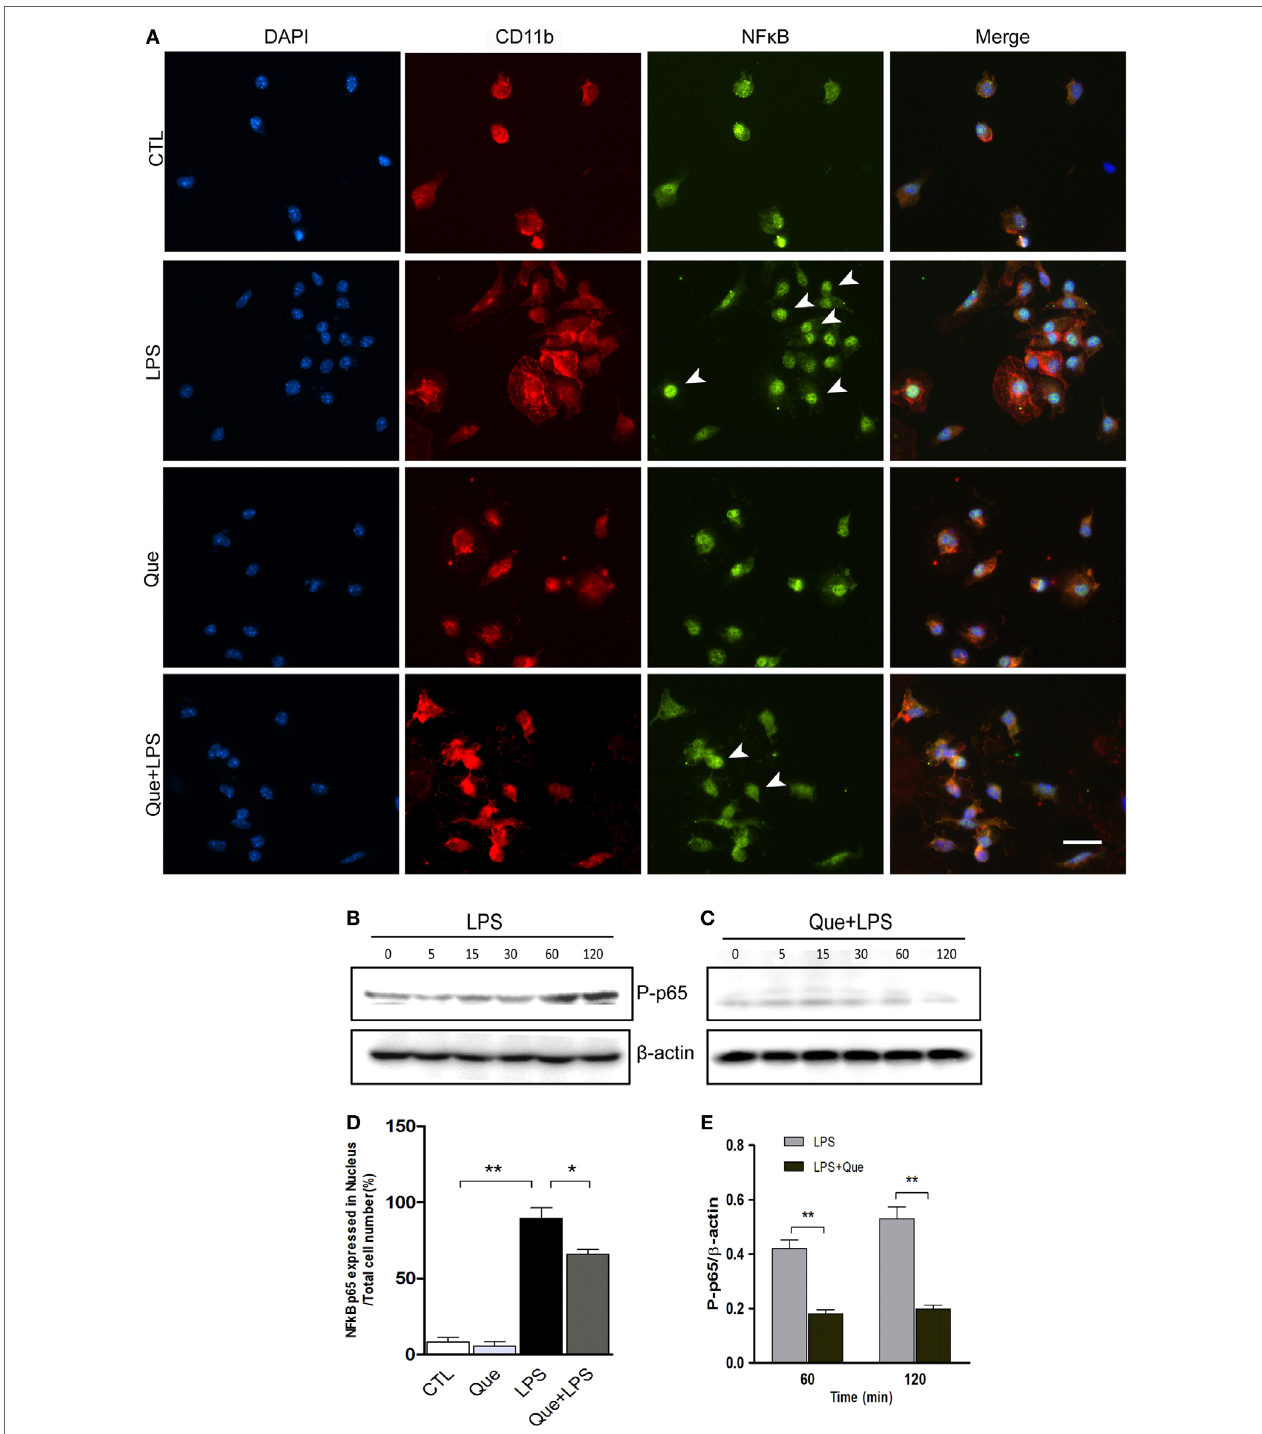
FigUre 5 | effect of Que on activation of nF- κ B in n9 cells induced by lPs . (a) Representative double IF staining of NF- κ B p65 (green) and CD11b (red) in N9 cells exposed in LPS with or without Que (10 μ M) pretreatment, nuclei were stained with DAPI (blue). Note: the arrow indicated positive staining in the nucleus. Scale bars: 50 μ m. (D) Quantification of the relative ratio of nucleus NF- κ B p65 in the indicated groups. Note: LPS significantly increased the ratio of nucleus NF- κ B p65, which could be reduced by Que pretreatment. (B , c) Western blot analysis of phosphorylated NF- κ B p65 in N9 cells exposed in LPS with or without Que pretreatment at indicated time points. β -actin was used as a loading control. Note: the phosphorylated NF- κ B p65 level was increased since 60 min after LPS treatment, and this pattern was attenuated by Que. (D , e) Quantification of the Western blot showing phosphorylated levels of NF- κ B p65 in N9 cells exposed to LPS with or without Que pretreatment. Values are mean ± SEM. * p < 0.05 and ** p < 0.01 vs. indicated